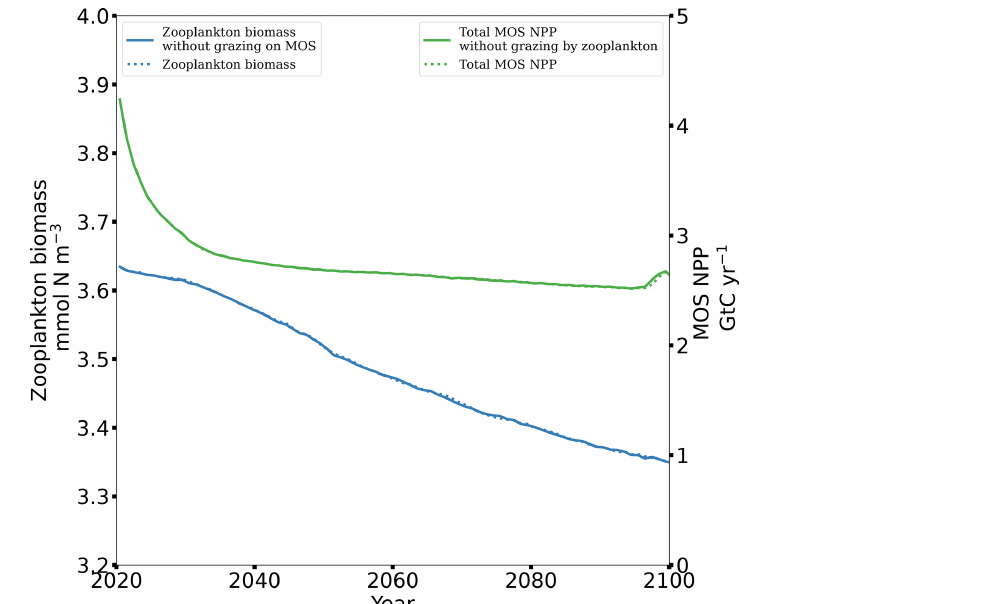
Figure B12. Global profiles of zooplankton biomass (left y axis) and macroalgal NPP of MOS (right y axis) with and without zooplankton grazing on macroalgae. The “zooplankton” communities do not have large effects, via grazing, on macroalgae NPP or its own biomass.